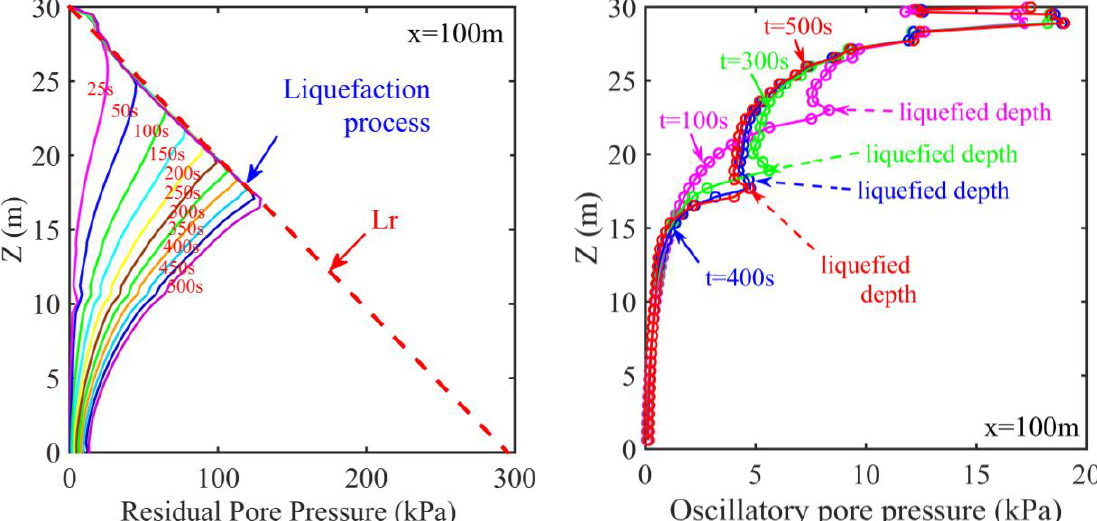
Figure 11. Vertical distribution of cnoidal wave-induced residual pore pressure and oscillatory pore pressure on x = 100 m.